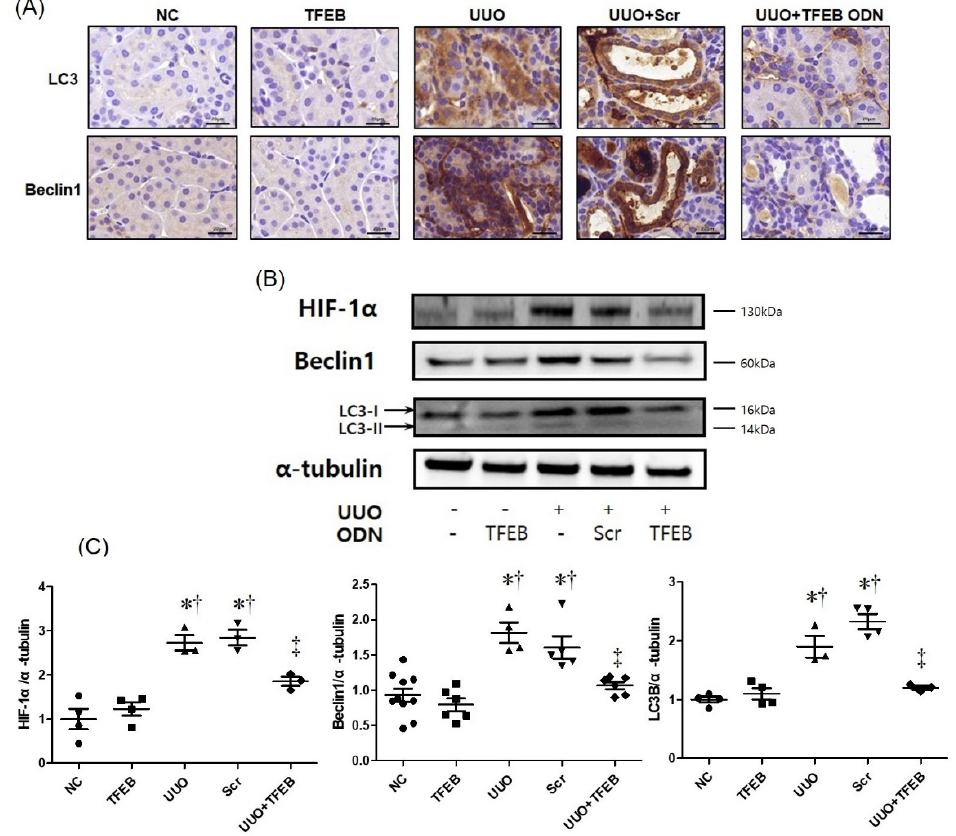
Figure 3. TFEB decoy ODNs decreased the expression of autophagic markers in UUO-induced renal injury. TFEB decoy ODN inhibits the expression of autophagy genes in UUO-induced renal fibrosis. ( A ) Immunohistochemical staining shows that the expressions of LC3 and Beclin1 proteins were reduced via TFEB decoy ODN administration in UUO-induced renal fibrosis mice. Original scale bar = 20 µ m. ( B ) Western blot analysis shows that TFEB decoy ODN decreased the expression of HIF-1 α , Beclin1, and LC3. ( C ) Quantification of the protein expression levels of the Western blot images using the Image J program. The results are expressed as mean ± SE of three independent experiments. * p < 0.05 vs. the NC group. † p < 0.05 vs. the TFEB group. ‡ p < 0.05 vs. the UUO or Scr group. NC, normal control group; TFEB, TFEB decoy injection in the normal control group; UUO, UUO surgery group; Scr, scramble ODN injection in the UUO surgery group; UUO + TFEB, TFEB decoy ODN injection in the UUO surgery group; LC3, microtubule-associated protein light chain 3; HIF-1 α , hypoxia-inducible factor-1 α ; UUO, unilateral ureteral obstruction; decoy ODNs, decoy oligonucleotides; TFEB, Transcription factor EB; Scr,